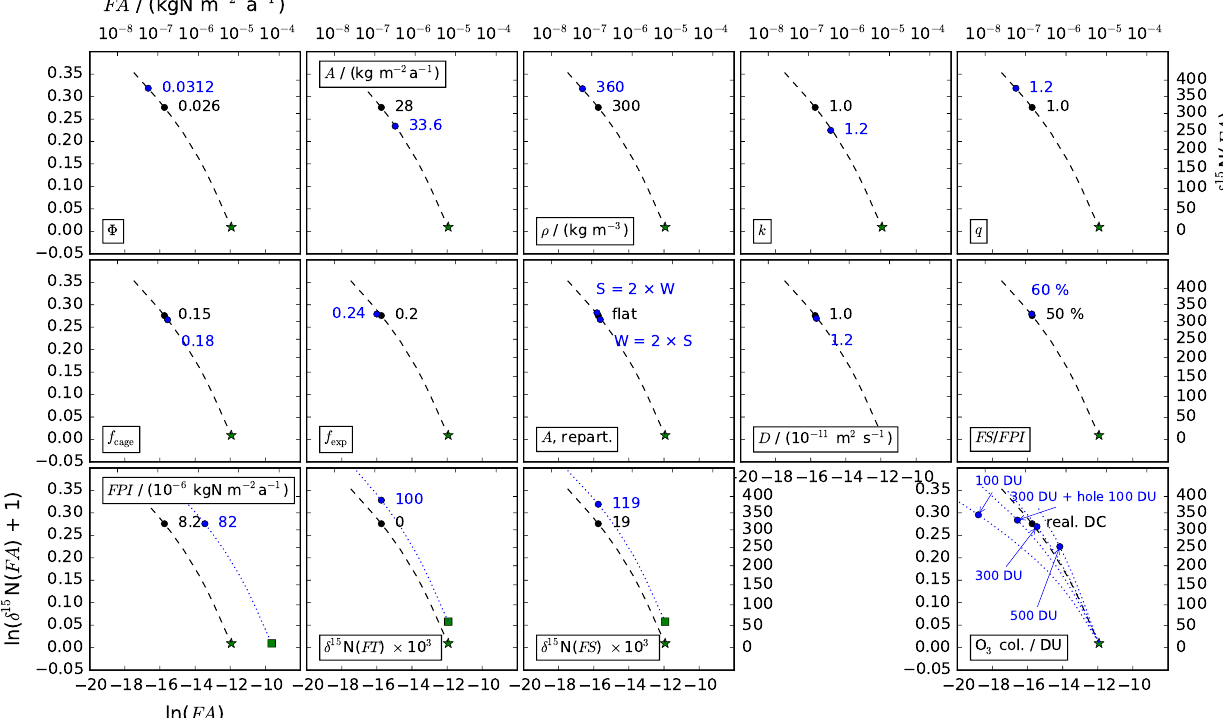
Figure 9. Modified Rayleigh plots of the sensitivity tests to the TRANSITS model. Only the tests which imply significant changes in FA and δ 15 N(FA) are shown. The green star represents the starting point, whose coordinates are (ln(FPI), ln( δ 15 N(FA) + 1)), and the thick dashed lines represent the curve which is obtained for the realistic DC simulation ( (cid:56) varied). The other dashed blue curves represent the consequences of a change in the starting point (squares) or in the ozone